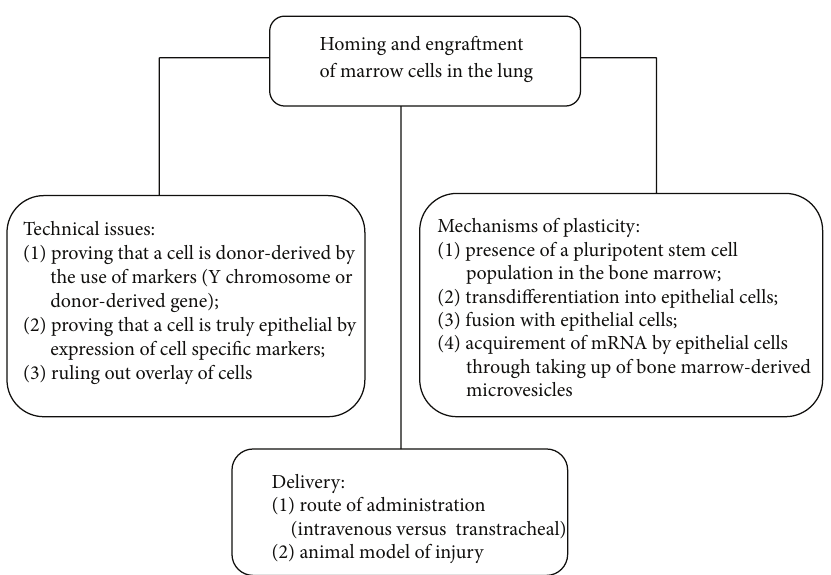
Figure 1: Still debated issues about homing and engraftment of marrow cells in the lung.